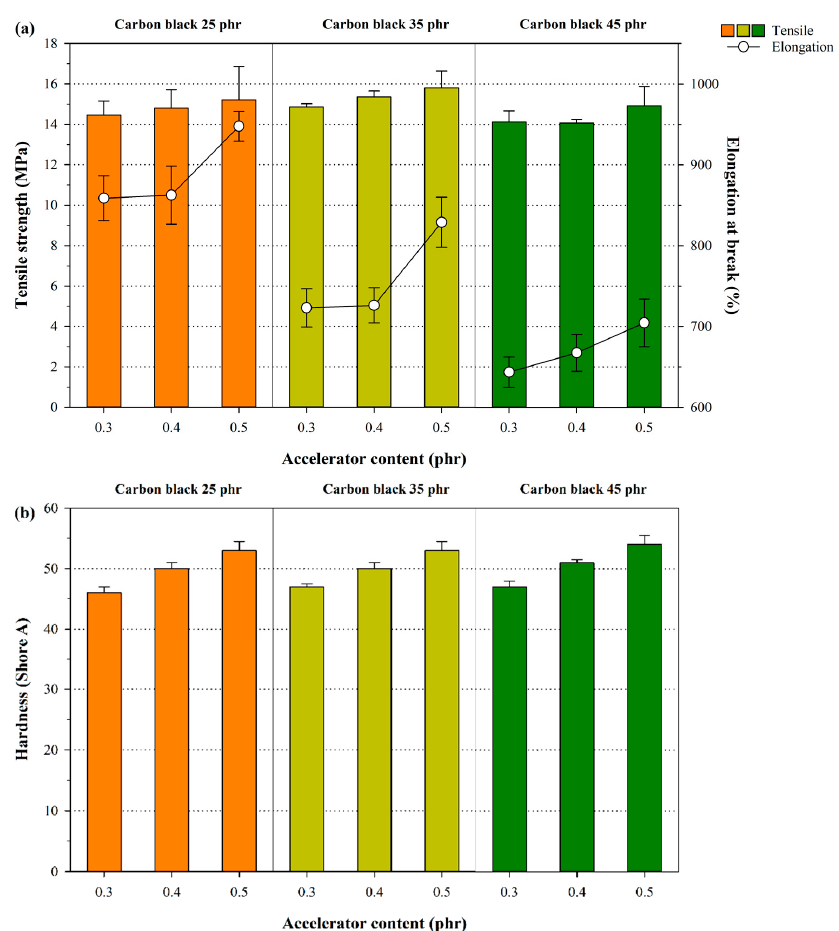
Figure 5. Variation in the mechanical properties in the NR samples by accelerator and carbon black regarding ( a ) tensile strength and elongation at break, and ( b ) hardness.